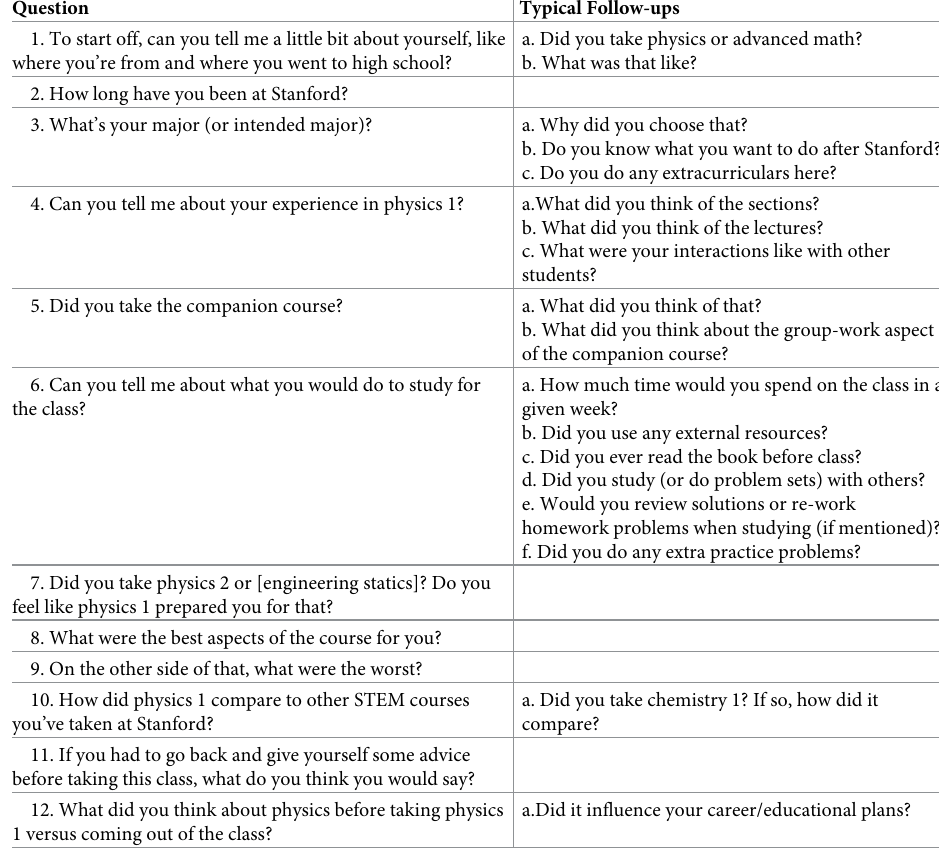
Table 2. Guiding and follow-up questions for student interviews. Not all questions were asked exactly as